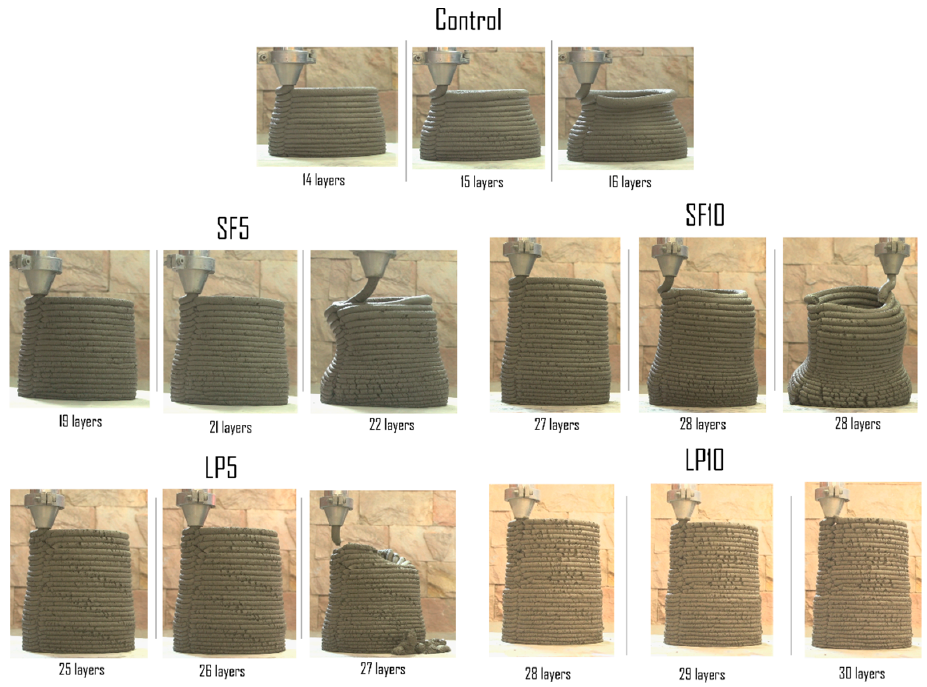
Figure 8. Comparison of buildability (in terms of number of layers) of cementitious mixtures.